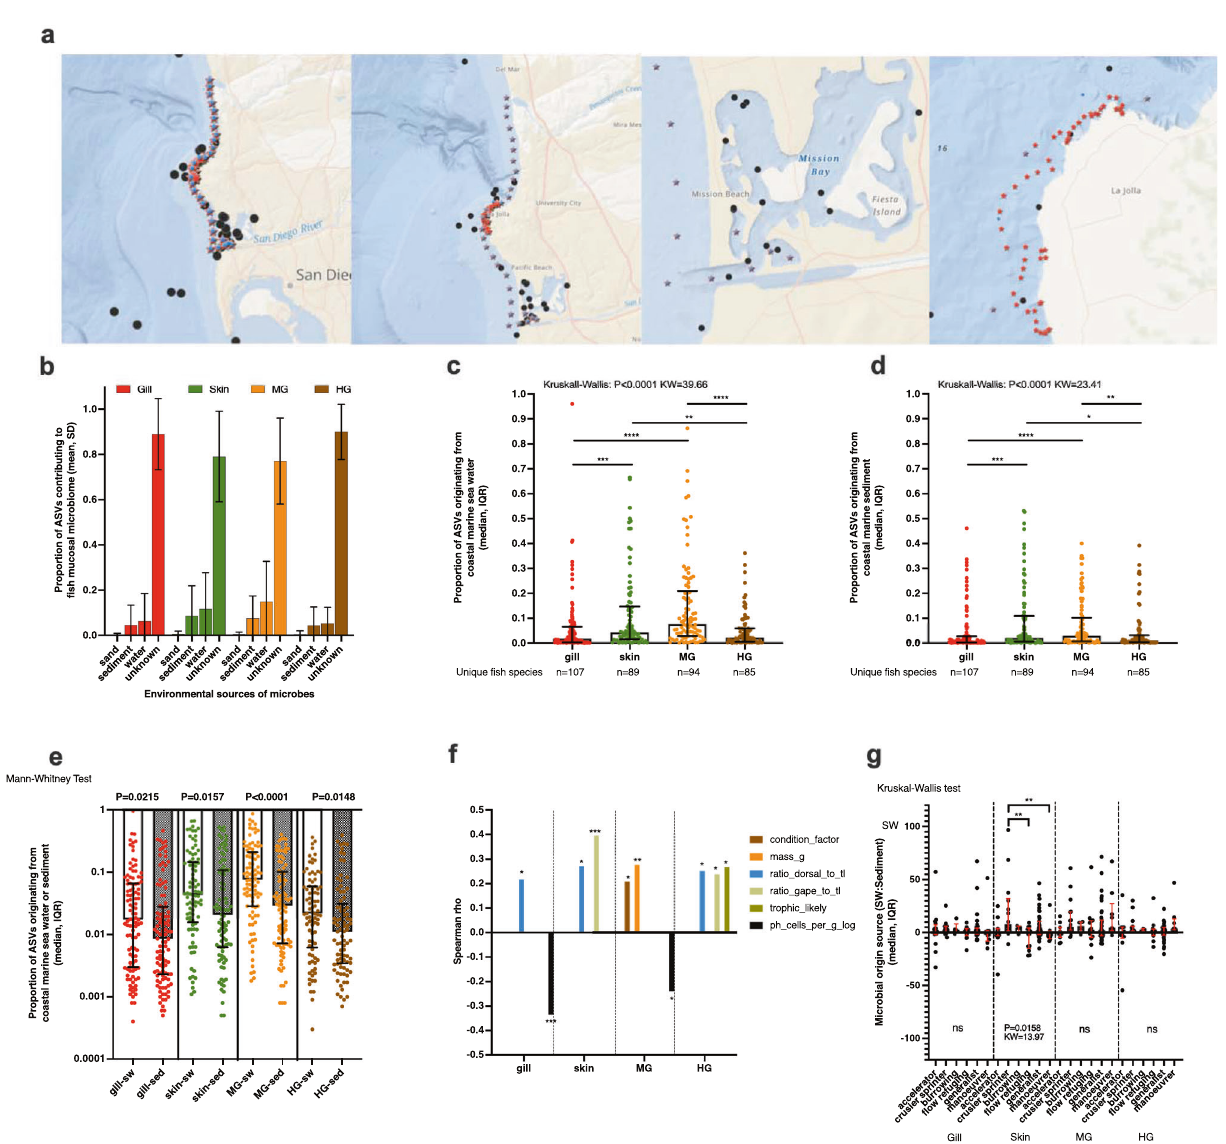
Fig. 7 | Microbial source tracking analysis. a Microbial sources of 60 sea water (bluecircle)samplestakenfrom30uniquesamplingstationsfromtwotimepoints are distributed on a 10km transect from Torrey Pines beach to Mission Bay. Microbial sources of 108 marine sediment samples (red stars) from San Diego coastalenvironmentincludes60pairedsamples(samelocationsasseawater)from the same 10km transect along with 58 samples from the various reef habitats near La Jolla. Geographic data presented using ArcGIS. b Sourcetracker2 analysis of likely sources for the four body sites of the fi sh comparing contributions of beach sand, marine sediment, sea water, and “ unknown ” . Unknown refers to microbes from an unknown source which could include diet and other animals or locations not sampled. c Speci fi c microbial contributions of sea water to the four